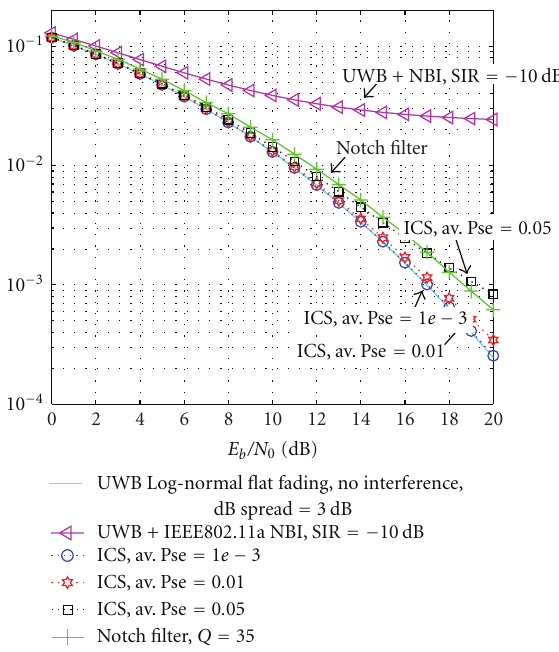
Figure 7: BER performance comparison of the ICS with a perfectly tuned Notch filter.